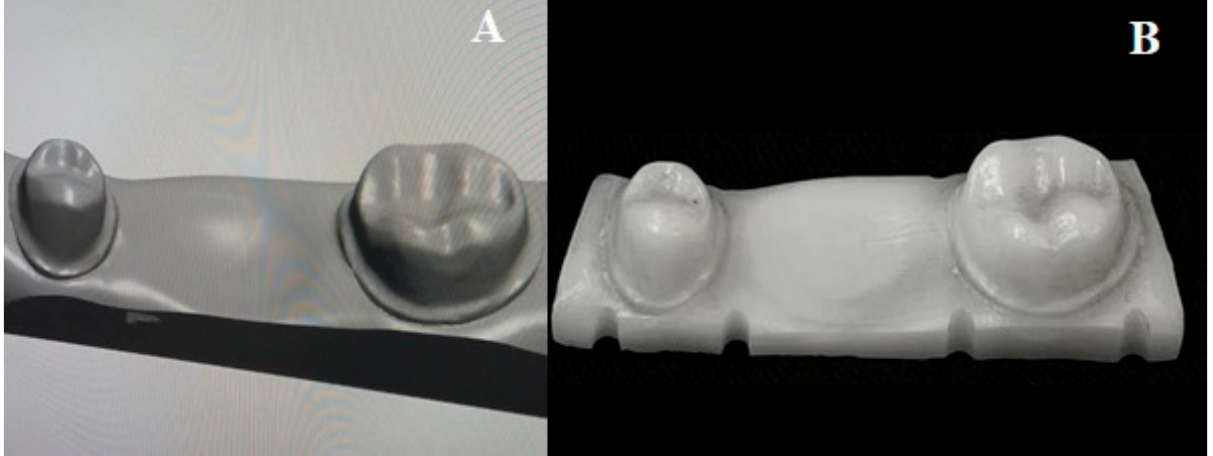
Figure 1. STL file for die ( A ) and the milled zirconia die for specimen testing ( B ) with scale bar 5 mm. According to the printing orientation, each material was printed with different printing orientations 0 ◦ , 45 ◦ , and 90 ◦ (Figures 4 and 5). After printing the specimens, 99%